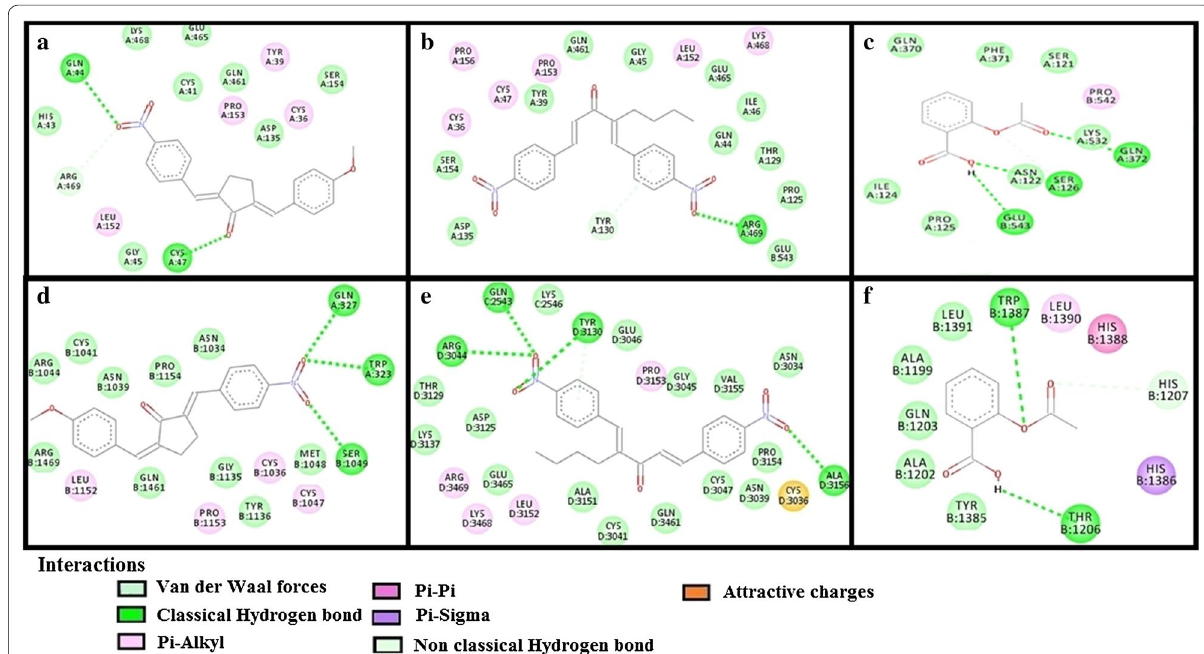
Fig. 4 a – c Represents interactions of ligands: (2 E ,5 E )‑2‑(4‑methoxybenzylidene)‑5‑(4‑nitrobenzylidene) cyclopentanone (AK‑1a), (1 E ,4 E )‑4‑(4‑nitrob enzylidene)‑1‑(4‑nitrophenyl)oct‑1‑en‑3‑one (AK‑2a) and aspirin with target: cyclooxygenase‑1 (COX‑1) respectively. d – f Represents interactions of AK‑1a, AK‑2a and aspirin with target: cyclooxygenase‑2 (COX‑2) respectively, drawn through Biovia Discovery Studio Visualizer client 2016